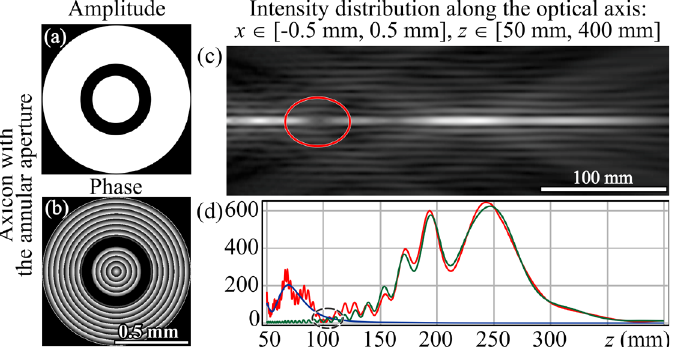
a flat beam, limited by radius R = 1.5 mm, with a wavelength λ = 532 nm. Ring screen radii